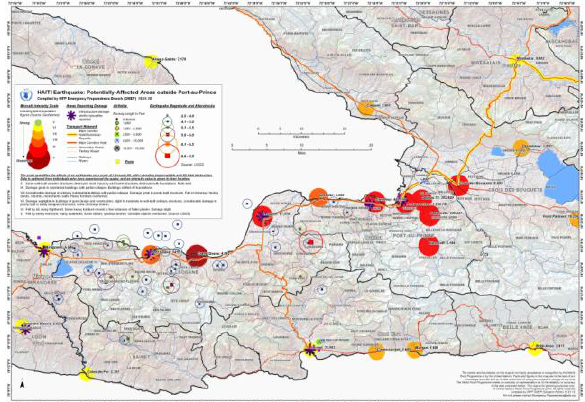
Figure 2. Haiti: Potentially-Affected areas outside Port-au- Prince (Source: UN